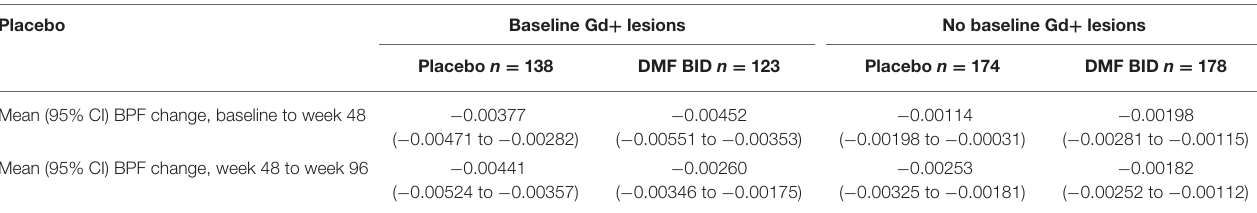
TABLE 3 | Model-estimated mean brain volume changes in patients with and without baseline Gd +